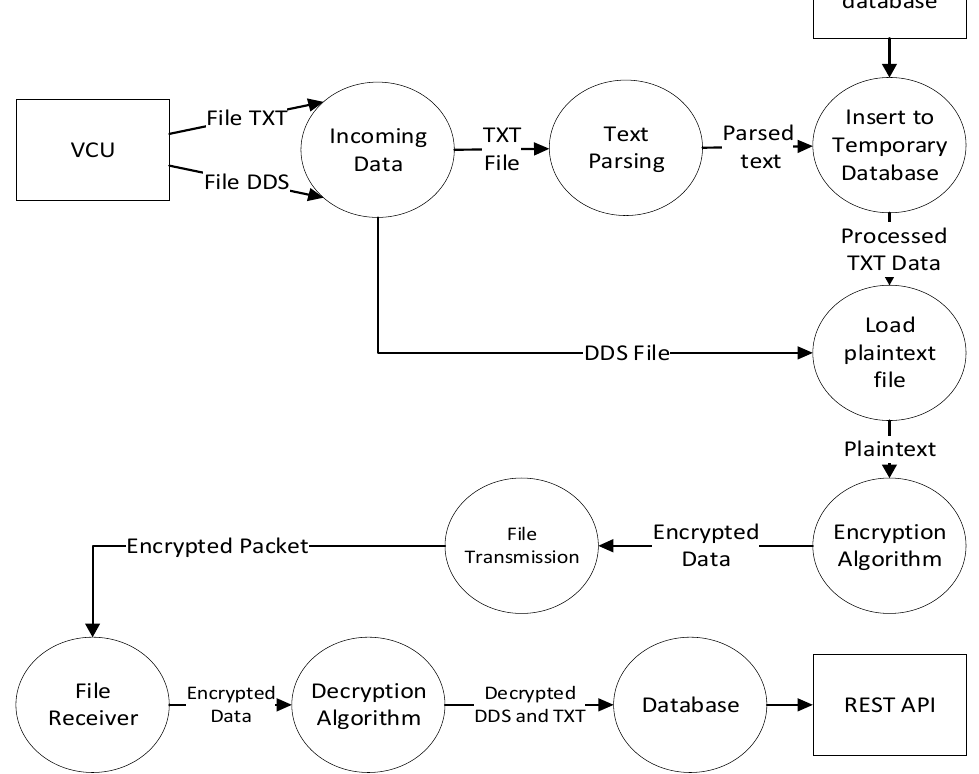
Figure 6. Securebox HSM DFD Level 1.